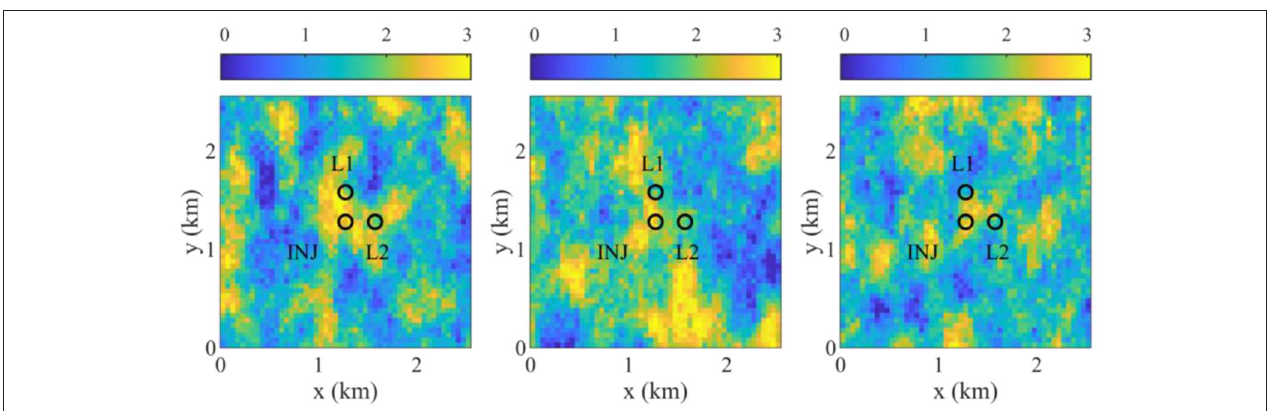
FIGURE 4 | Top view of log 10 permeability (md) of 3 of 20 geological models, and the locations of an injector (INJ) and two leaky abandoned wells (L1 and L2).